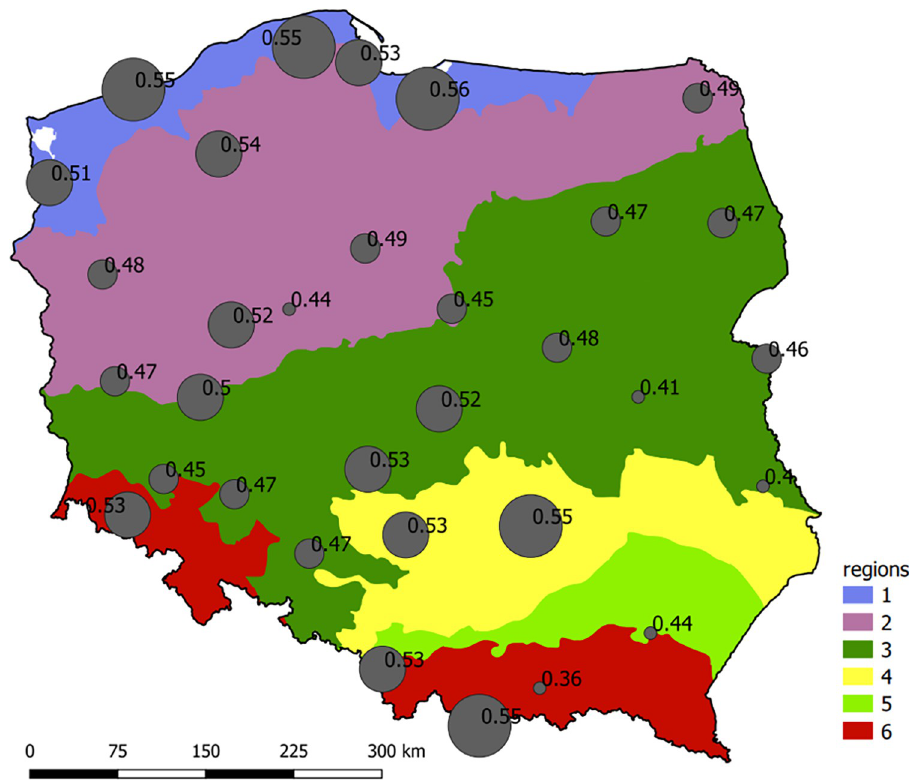
Fig 8. Maximum catchment imperviousness (Imp gr ) for the analyzed rainfall stations, the exceedance of which results in stormwater flooding in the small urban catchments (region names are listed in Fig 1).